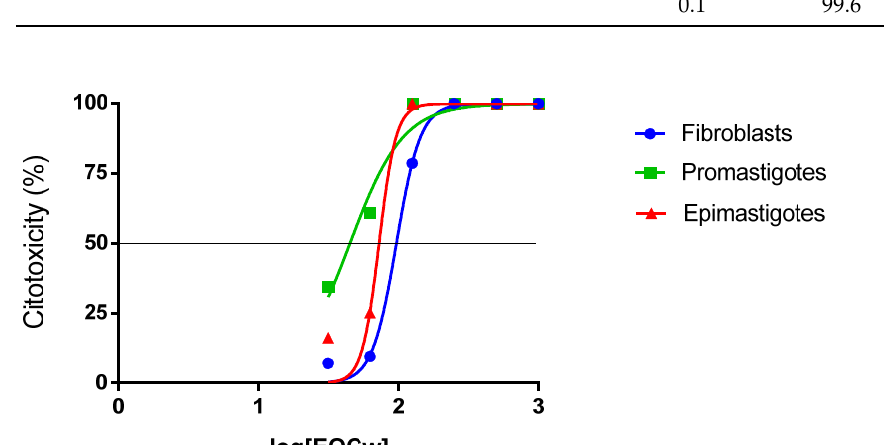
Figure 5. Log-dose vs. cytotoxicity curves for NCTC 929 fibroblasts, L. braziliensis promastigotes, and T. cruzi epimastigotes were estimated by non-linear regression of means.